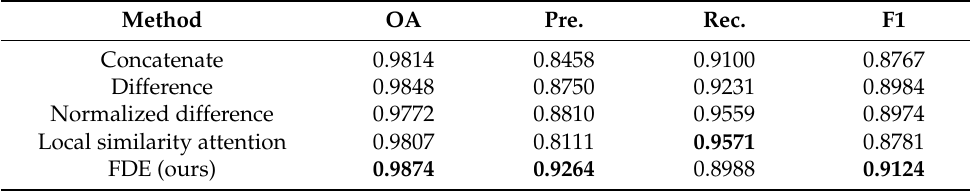
Table 3. Results generated by several similarity measures on the BCDD